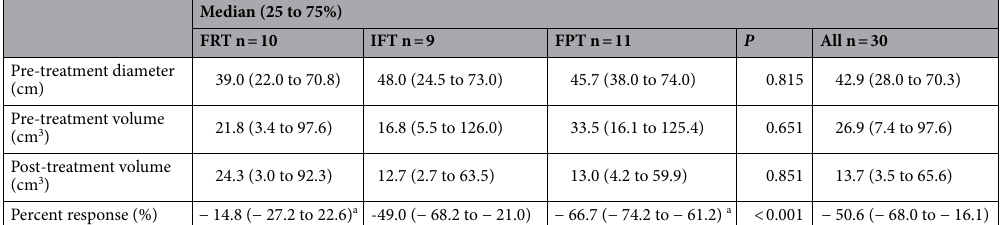
Table 2. Pre- and post-treatment volumes of angiomyolipomas and percent responses according to the tumor fat profile. Comparisons among FRT, IFT and FPT were performed with Krusk l-Wallis test. Post-test significance was corrected using the Bonferroni method. a P < 0.001 in the post-test analysis. FPT fat-poor tumor, FRT fat-rich tumor, IFT intermediate-fat